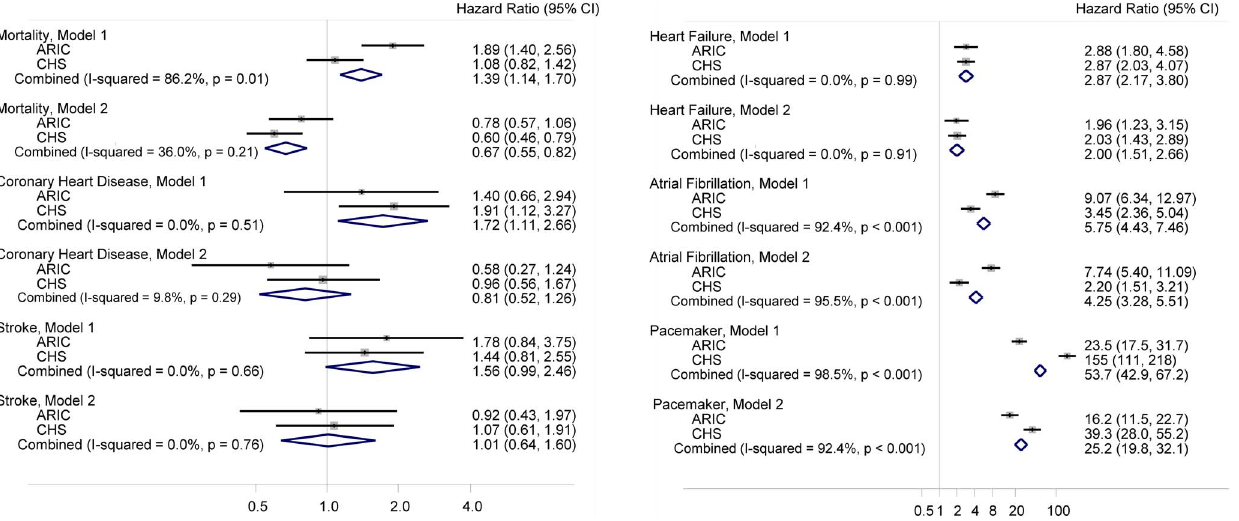
Figure 2. Cohort-specific and pooled hazard ratios (95% confidence intervals) of mortality and selected cardiovascular diseases comparing individuals with and without sick sinus syndrome (SSS), Atherosclerosis Risk in Communities (ARIC) study, 1987–2009, and Cardiovascular Health Study (CHS), 1989–2008. Model 1: Cox proportional hazards model adjusted for age, sex, race, study center, education, smoking, body mass index, hypertension, total cholesterol, HDL cholesterol, diabetes, prevalent coronary heart disease, prevalent heart failure, and prevalent stroke. Model 2: Adjusted as in model 1, and for incident coronary heart disease, incident heart failure, incident stroke and incident atrial fibrillation as time-dependent covariates.